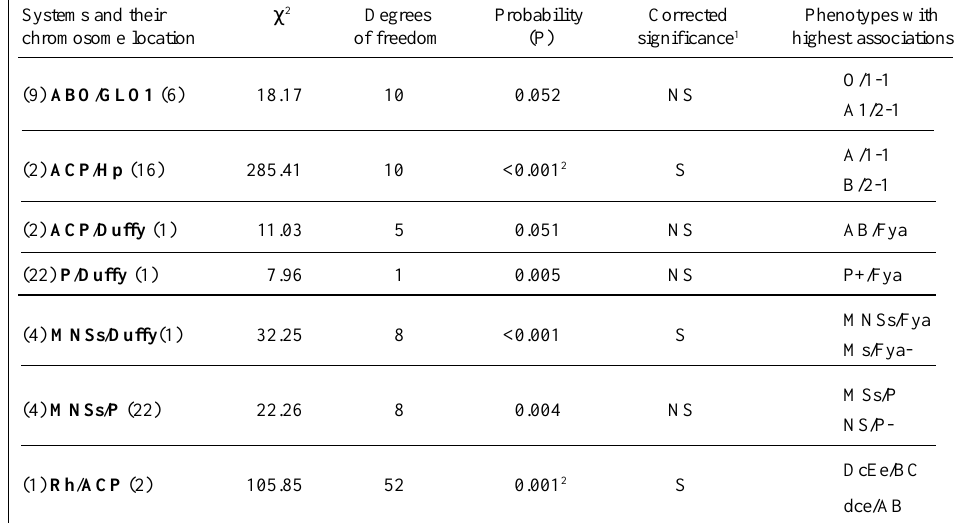
Table VII - Phenotype associations between systems (results significant at the 5% or lower levels). Systems and their